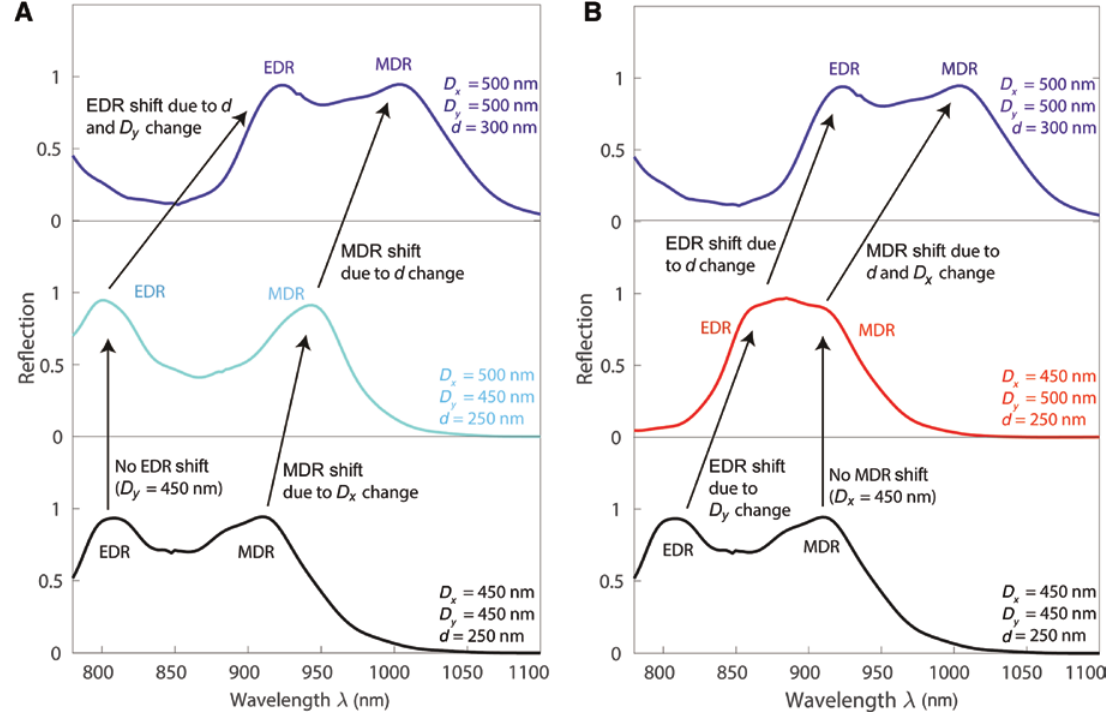
, D , and d between the cases x y = 450 nm, D = 500 nm, x y (black to red line) is comparable to the effect of the y